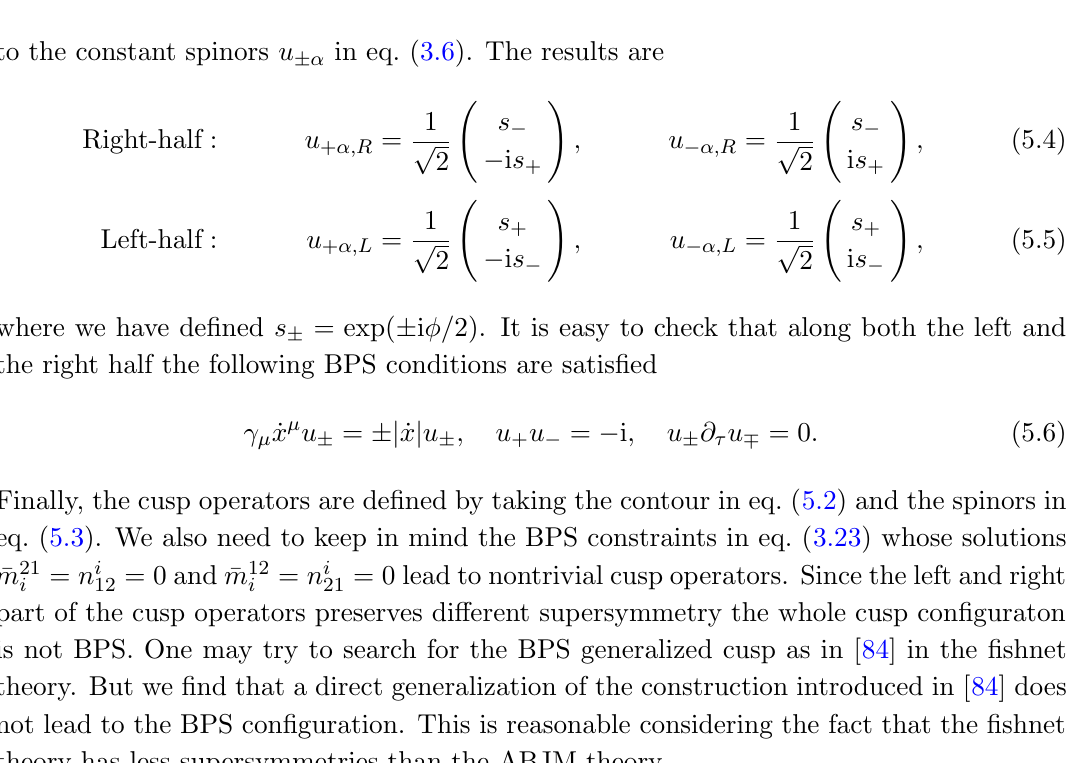
Figure 3 . One-loop Feynman diagrams for